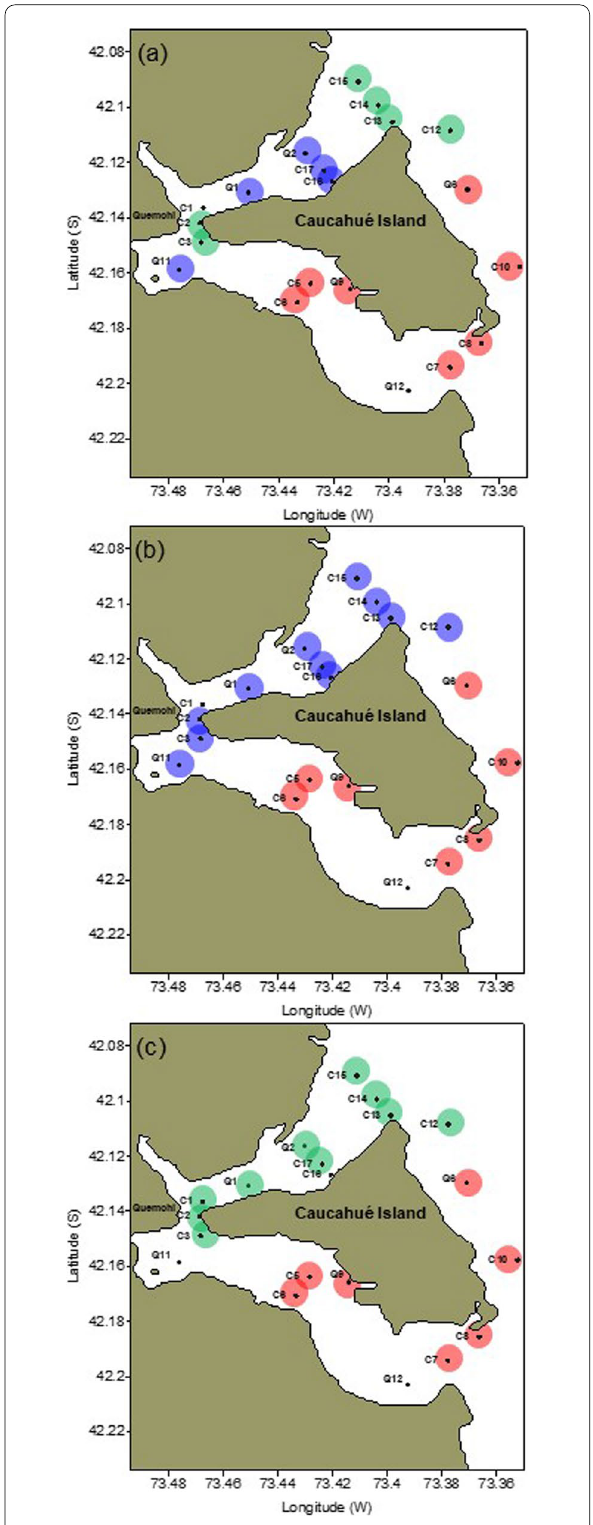
Fig. 4 A spatial assignment of consensus for statistically significant zooplankton groupings for the surface ( a , b ) and deeper strata ( c ) in Caucahué Channel. The colors of the circumferences identify the different